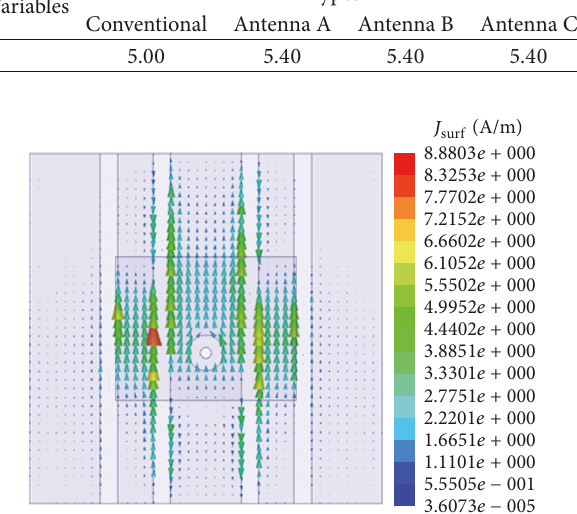
Figure 7: Vector current distribution of 0 degrees at 5.54 GHz.